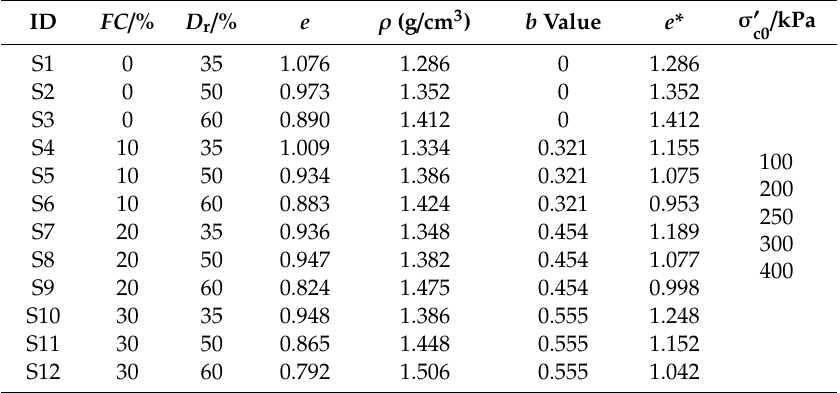
Table 3. Schemes of bender element tests for Nantong marine silty